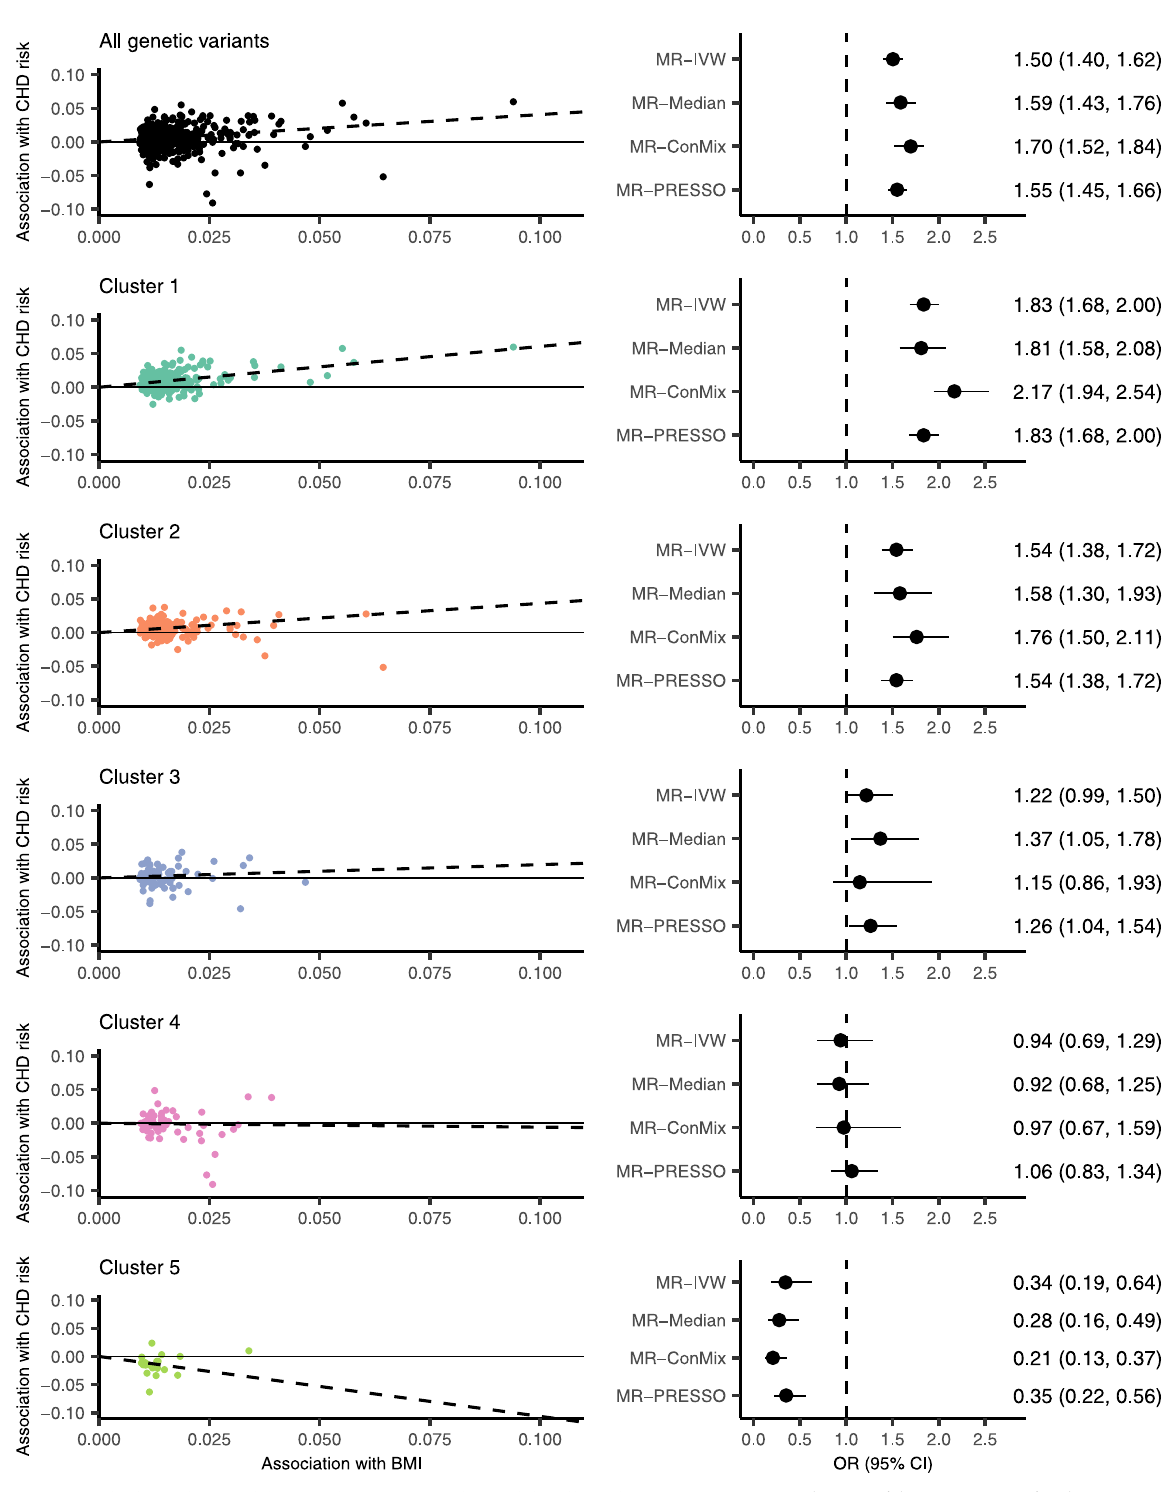
Fig 5. Results from the Mendelian randomization analyses of the effect of BMI on CHD. Scatterplots are of the associations of each genetic variant with BMI (standard deviation units) and the log odds ratio of CHD risk. The slopes of the dotted lines are the MR-IVW estimates for the respective cluster. Forest plots show the estimates and 95% confidence intervals from Mendelian randomization, for all genetic variants and for each cluster. Mendelian randomization estimates represent the change in odds ratio of CHD risk per 1 standard deviation increase in genetically predicted BMI. The dotted lines indicate an odds ratio of